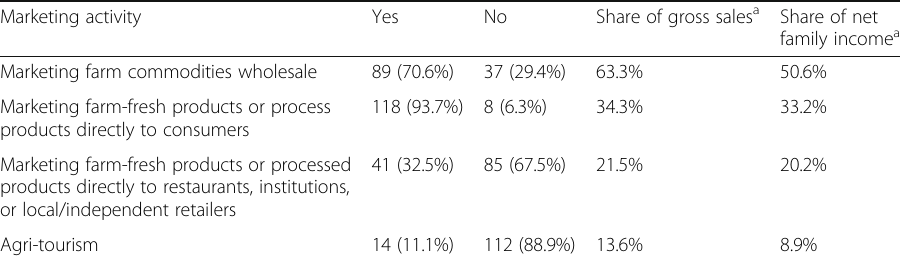
Table 3 Marketing methods among respondents ( N = 126) Marketing